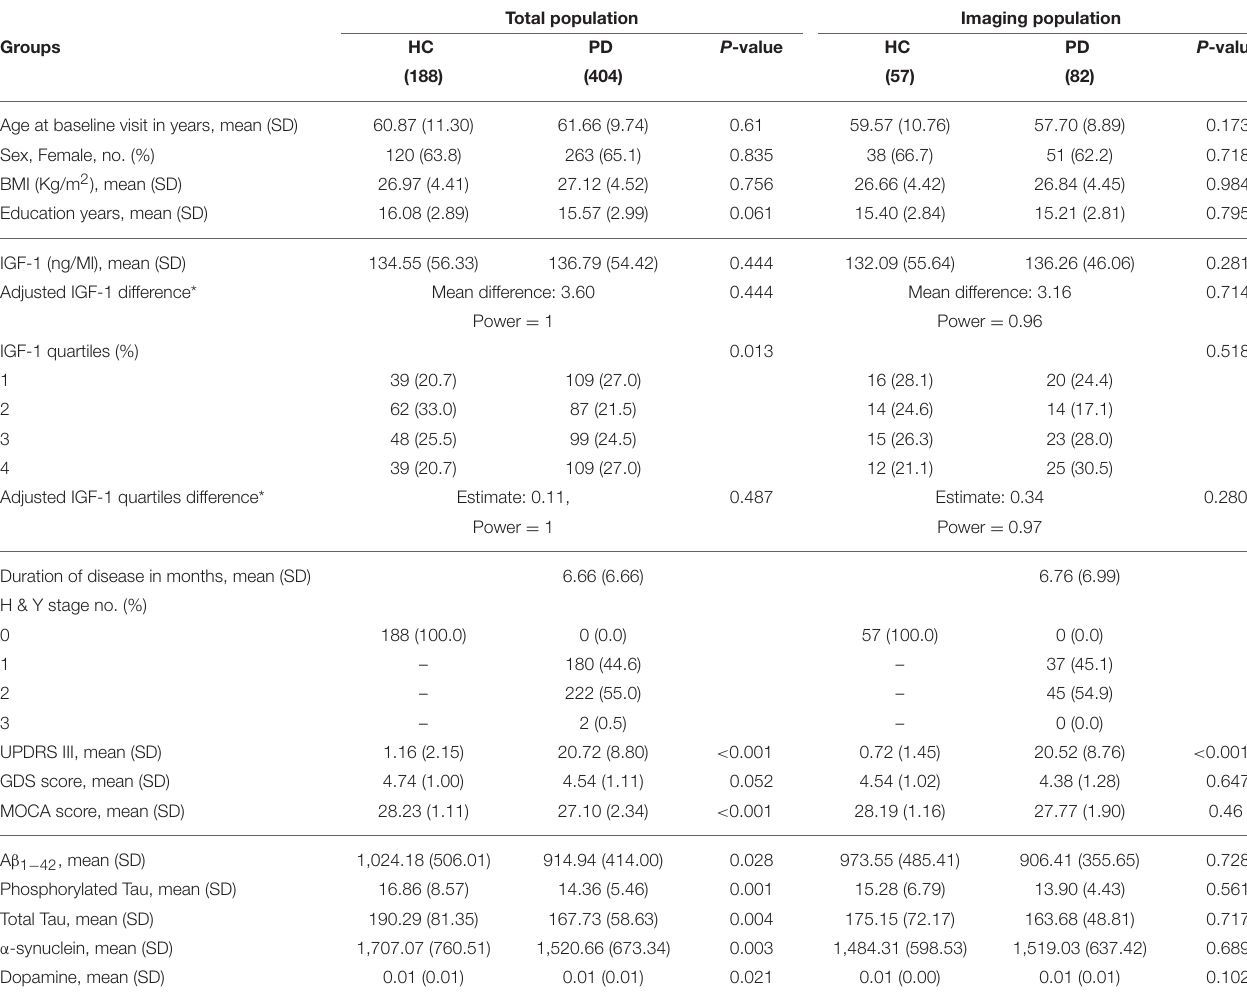
TABLE 1 | Demographic and baseline clinical data of participants. Total population Imaging